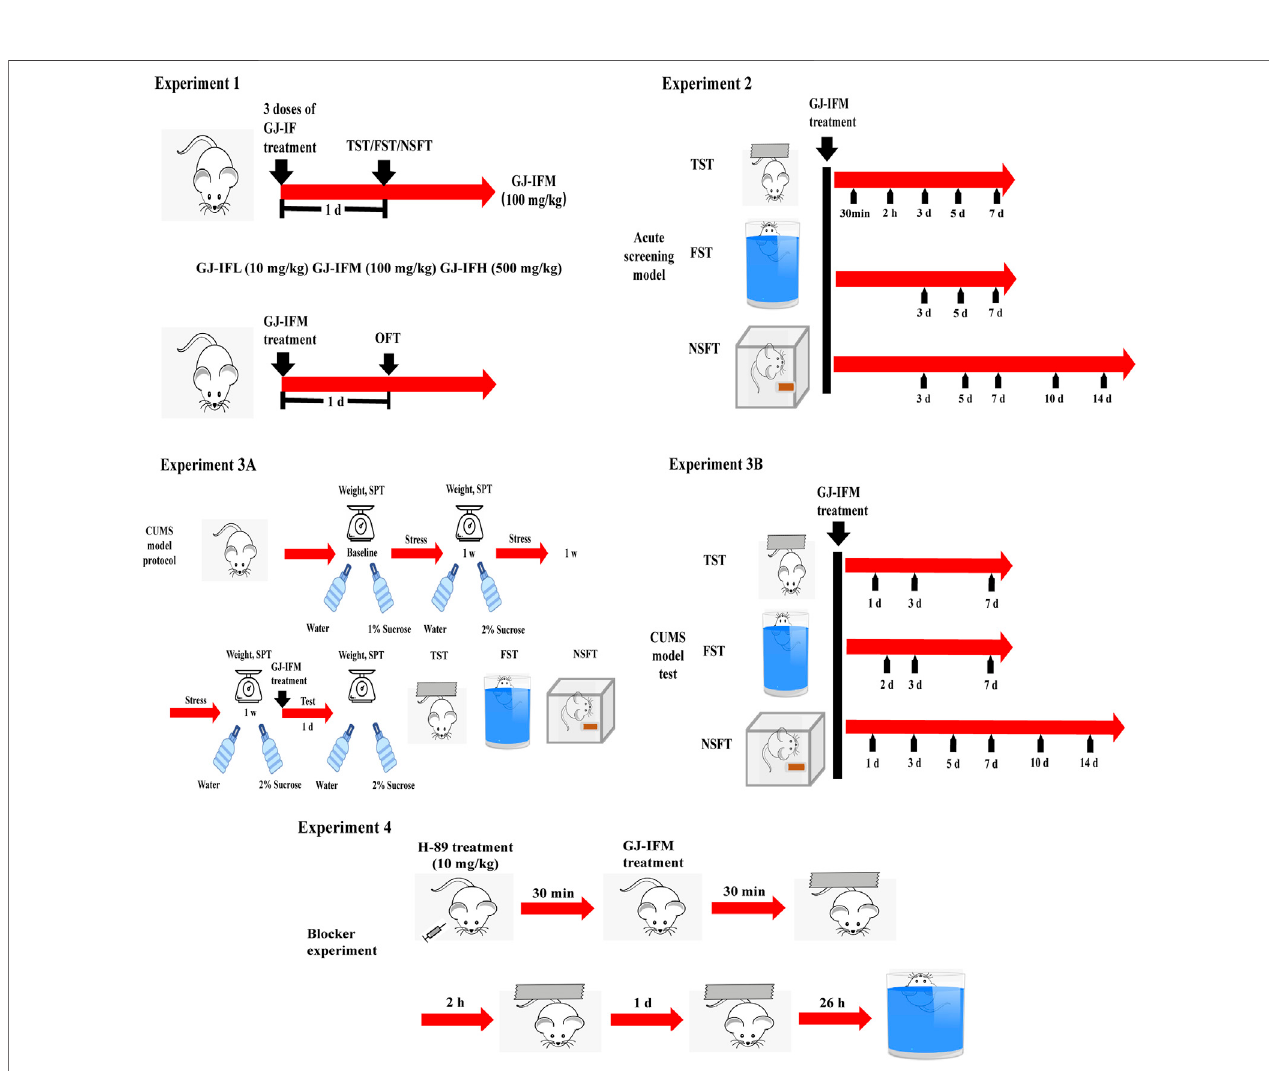
FIGURE 3 | Experimental timeline and design of behavioral experiment.